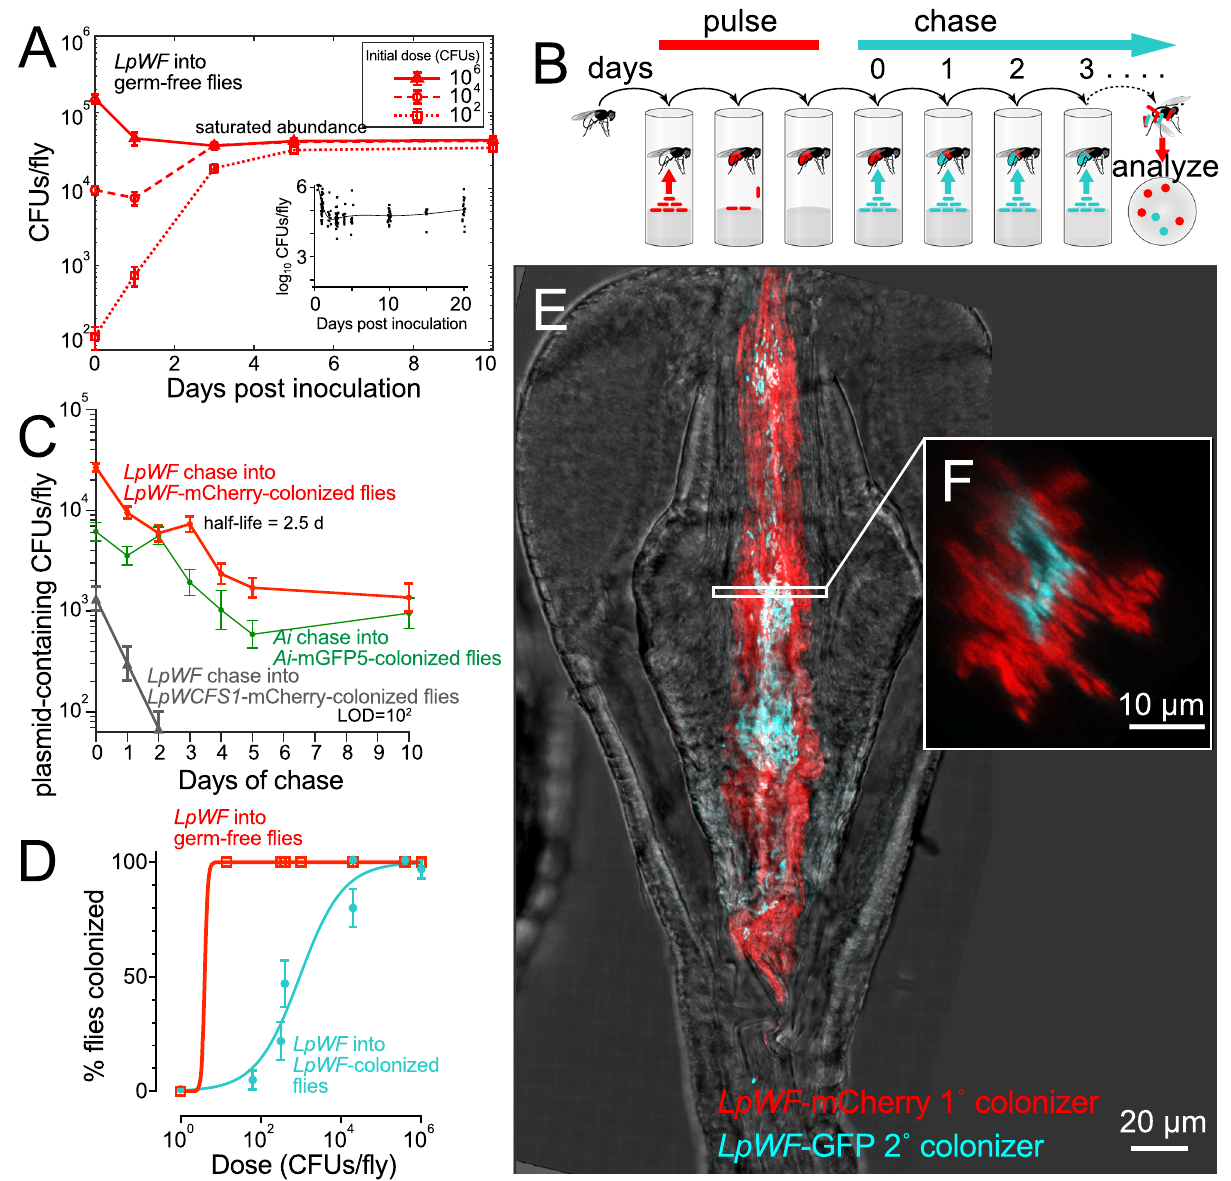
Fig. 2 | Kinetic properties of bacterial association suggest the existence of a niche in the proventriculus. A Saturation occurs over a colonization time course of germ-free fl ies by LpWF . Data points are mean of log 10 (CFUs) in n ≥ 48 fl ies/data point. Error bars represent 1s.e.m. Inset: 20-day time course after inoculation with 10 6 CFUs (data from 24 ). B Bacterialpulse-chase experimentaldesign: fl ies were fi rst pre-colonized with LpWF -mCherry, then fed an excess of unlabeled LpWF (blue) dailyonfreshfood. C Acterialcellturnoverquanti fi edbypulse-chasetimecourseof Lp -mCherry-pre-colonized fl ies continuously fed unlabeled LpWF or Ai -GFP-pre-